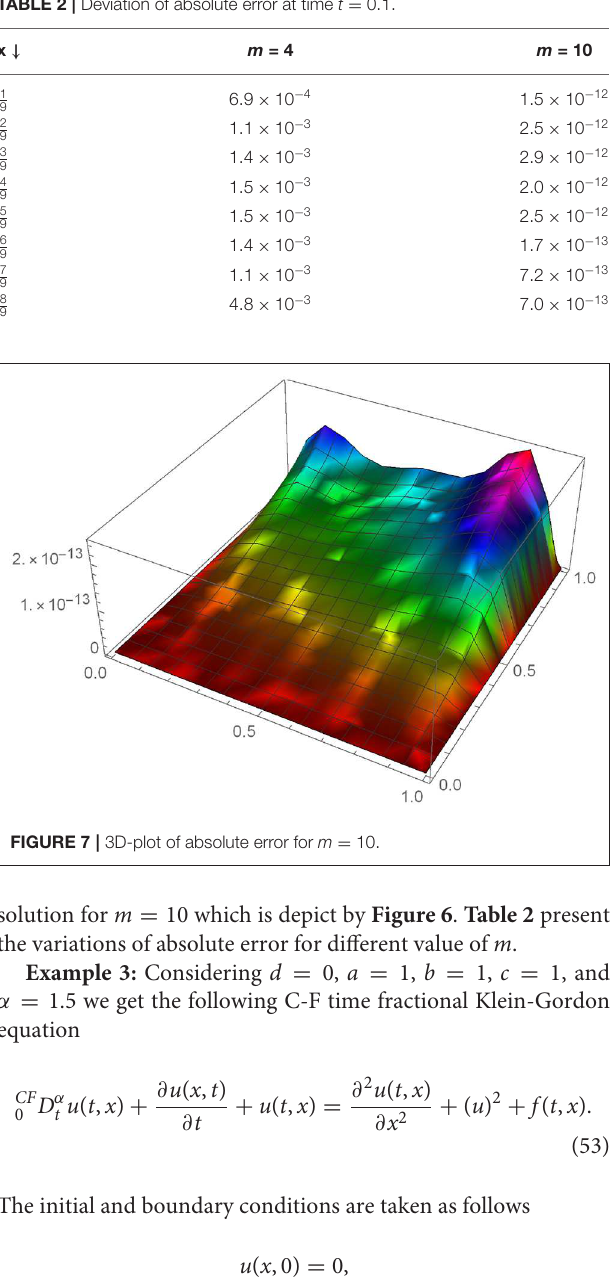
TABLE 2 | Deviation of absolute error at time t = 0.1.